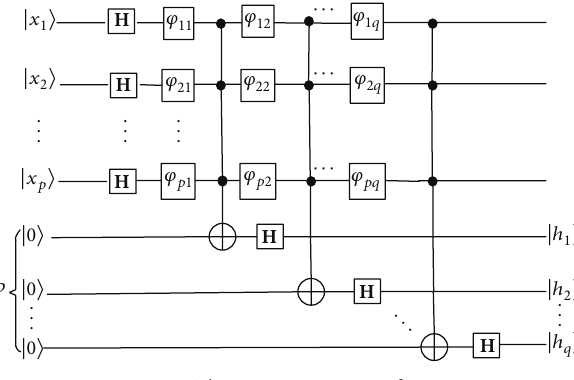
Figure 4: The quantum circuit of